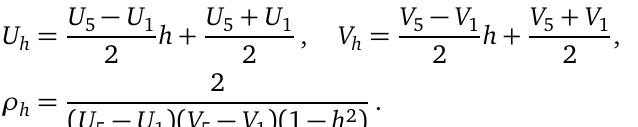
Figure 6: Illustration of EWCS in the non-adjacent case. The red curve is the EWCS Σ whose extension (the dashed blue line) ends at the balance points ( t AB ( t ) and the RT surface is disconnected E , x 3 3 normal to both the EWCS and E